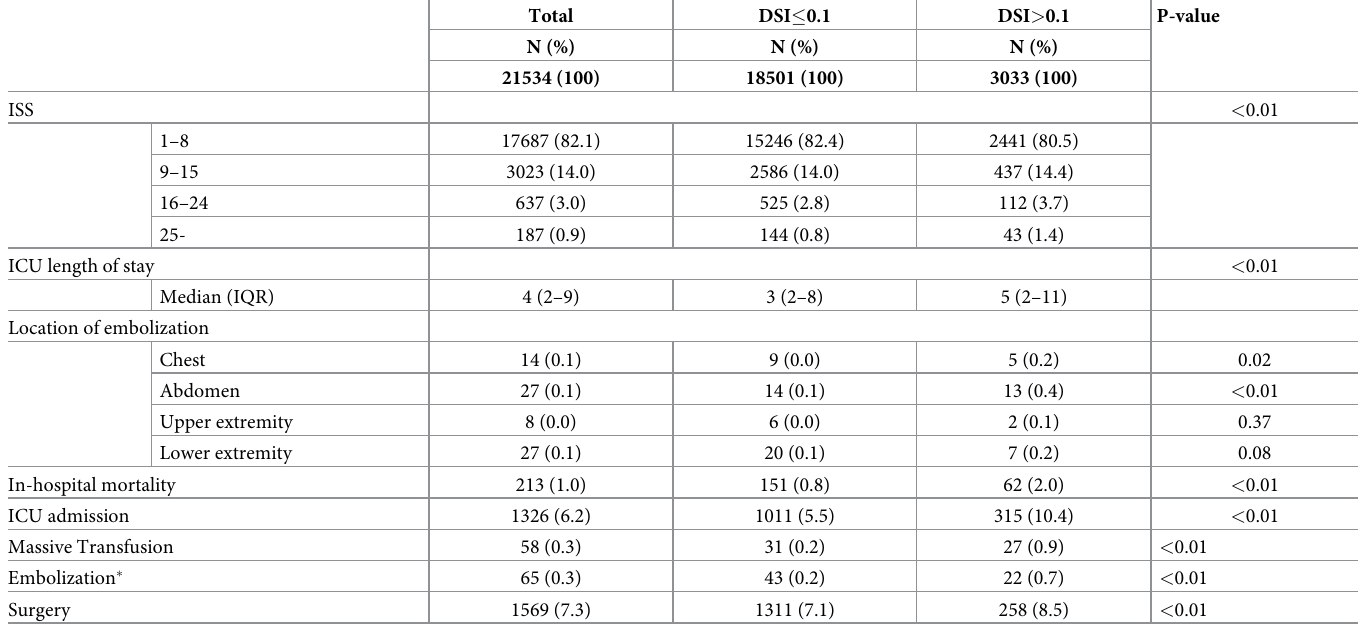
Table 2. In-hospital information and outcomes according to exposure groups.